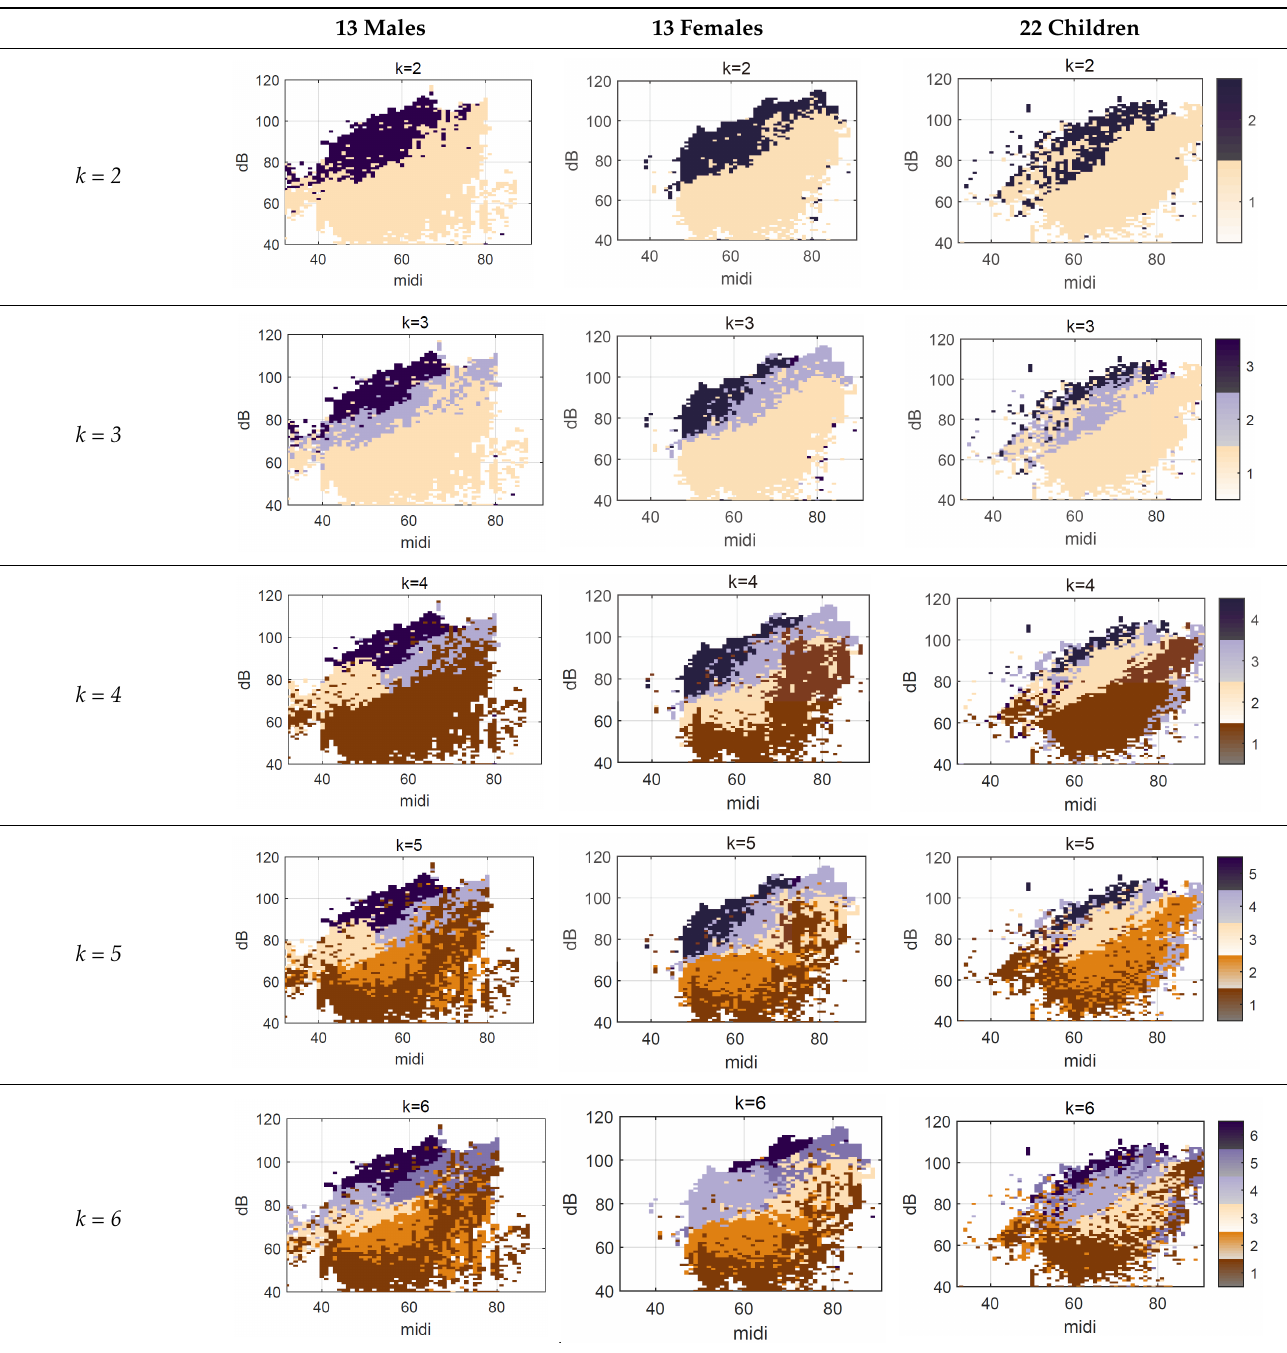
Overall, male voices generally have a larger pitch and volume range than females and children. In contrast, the female and the child’s voices are more concentrated. All three groups produce similar distributional trends with k = 2 and k = 3. Soft and loud